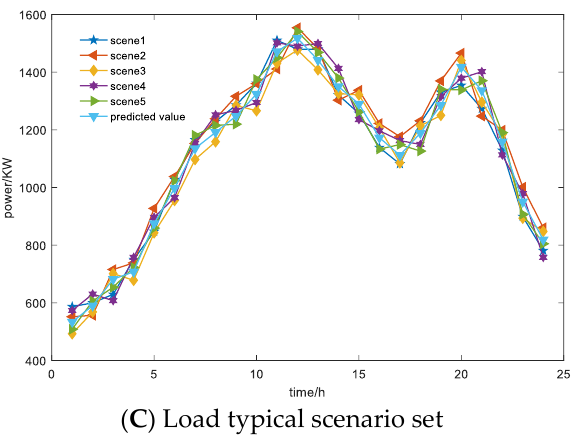
Figure 2. Wind power, PV output, and load power in typical scenarios.